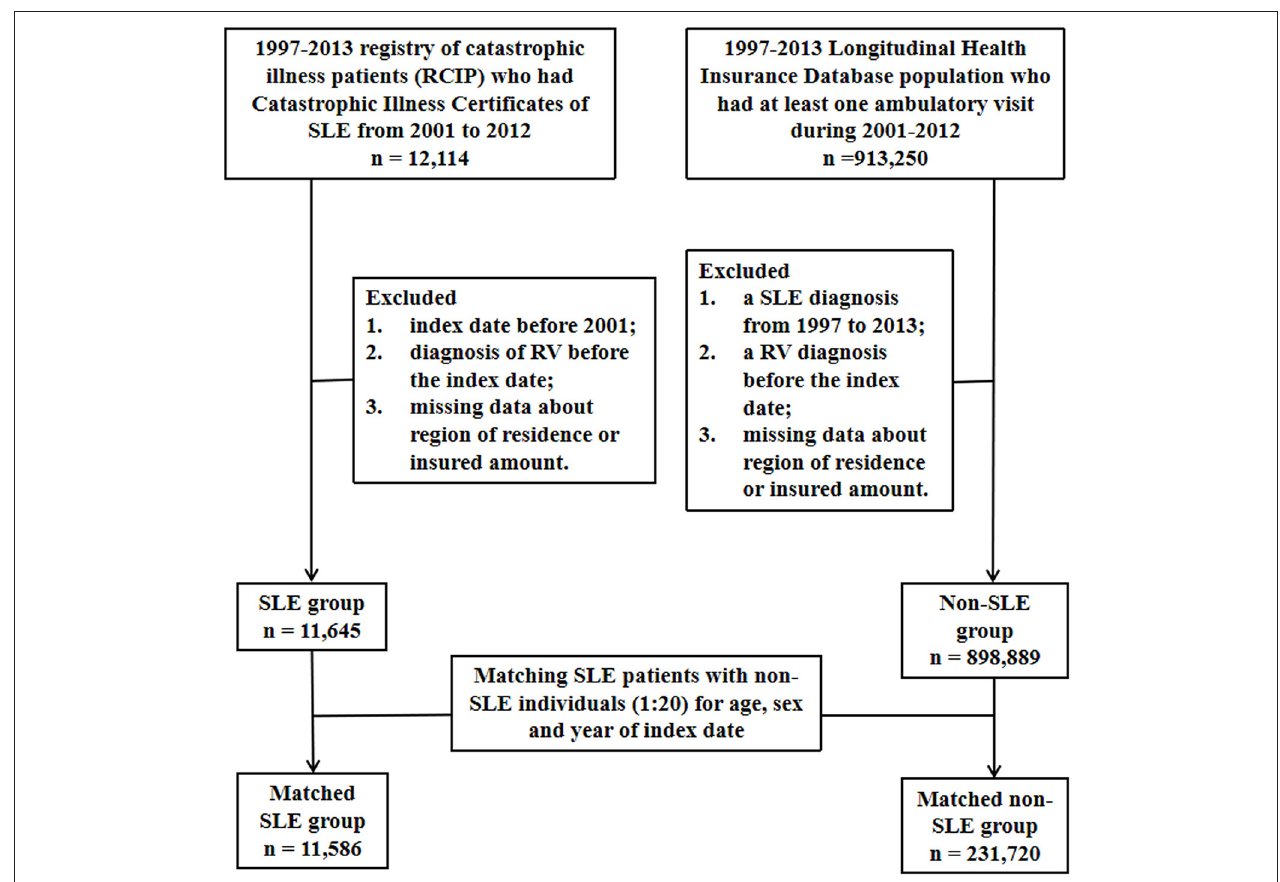
FIGURE 1 | Flowchart of the study design. SLE, systemic lupus erythematosus; RV, retinal